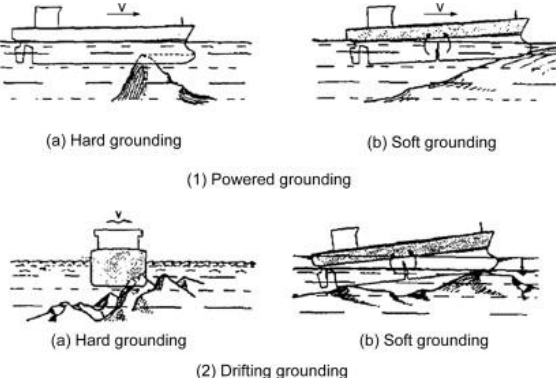
Figure 1. Schematic illustration of ship-grounding-based ship velocity [7]. Figure 1: Schematic illustration of ship-grounding-based ship velocity